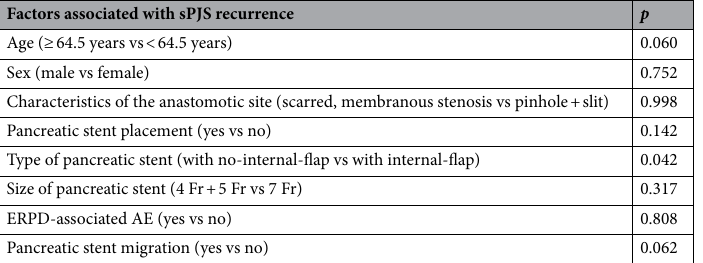
Table 5. Factors associated with sPJS recurrence. sPJS symptomatic pancreaticojejunal anastomotic stenosis, ERPD endoscopic retrograde pancreatic drainage, AE adverse events.